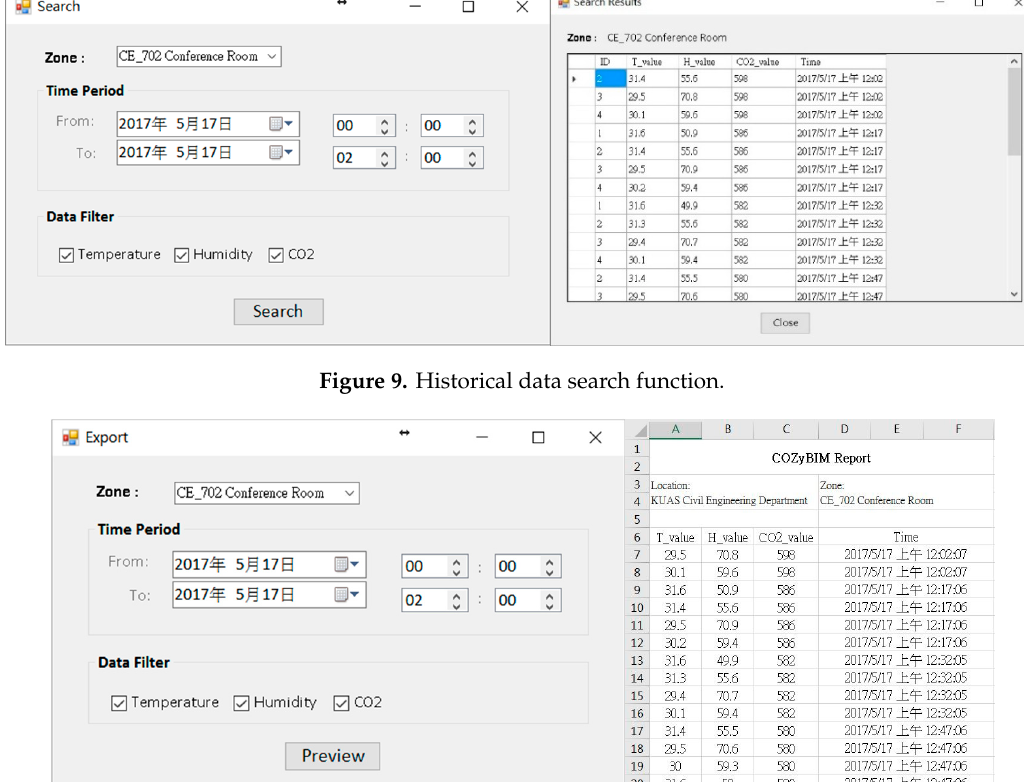
Figure 8. Advisor window and control window of COZyBIM. ( a ) Inductive Energy-Saving Module Function; ( b ) Smart Control Module Function Window.